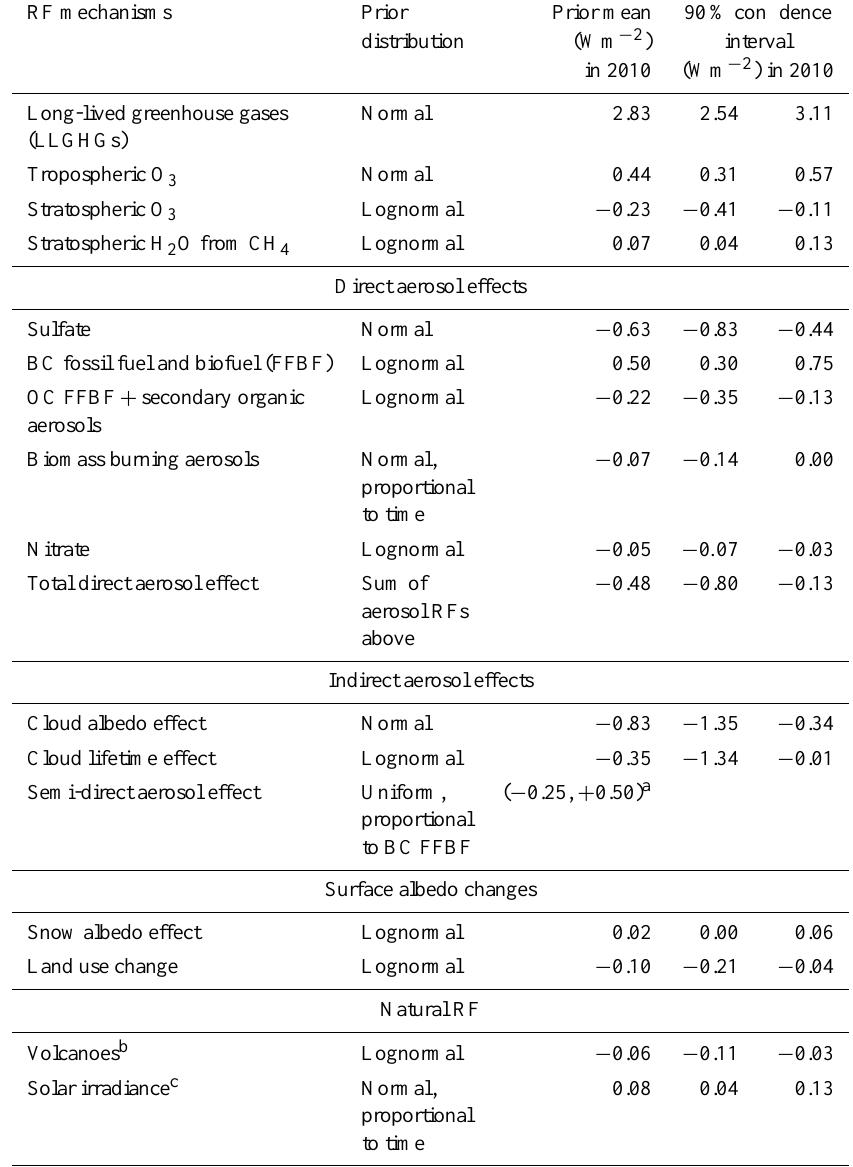
Table 1. The RF mechanisms included with information on the prior distribution assumed and the prior mean value and the 90% confidence interval in the year 2010. The RF values are relative to